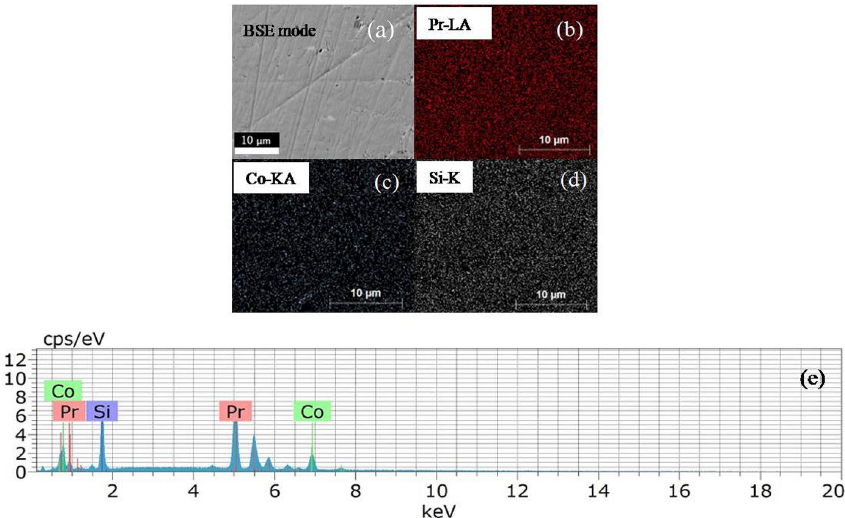
Figure 3. (a) Backscattered electron (BSE) image and (b–d) elemental mapping by SEM equipped with EDX on the surface of Pr 2 Co 0.86 Si 2.88 from the region presented in (a) . (e) presents EDX results of Pr 2 Co 0.86 Si 2.88 .